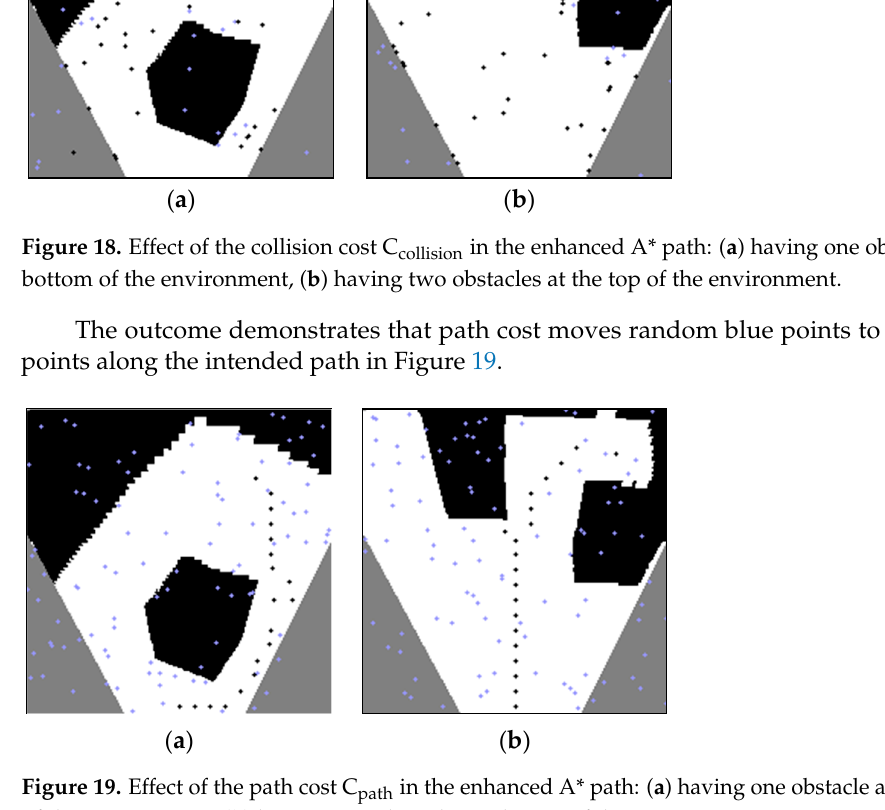
Figure 19. Effect of the path cost C path in the enhanced A* path: ( a ) having one obstacle at the bottom of the environment, ( b ) having two obstacles at the top of the environment.